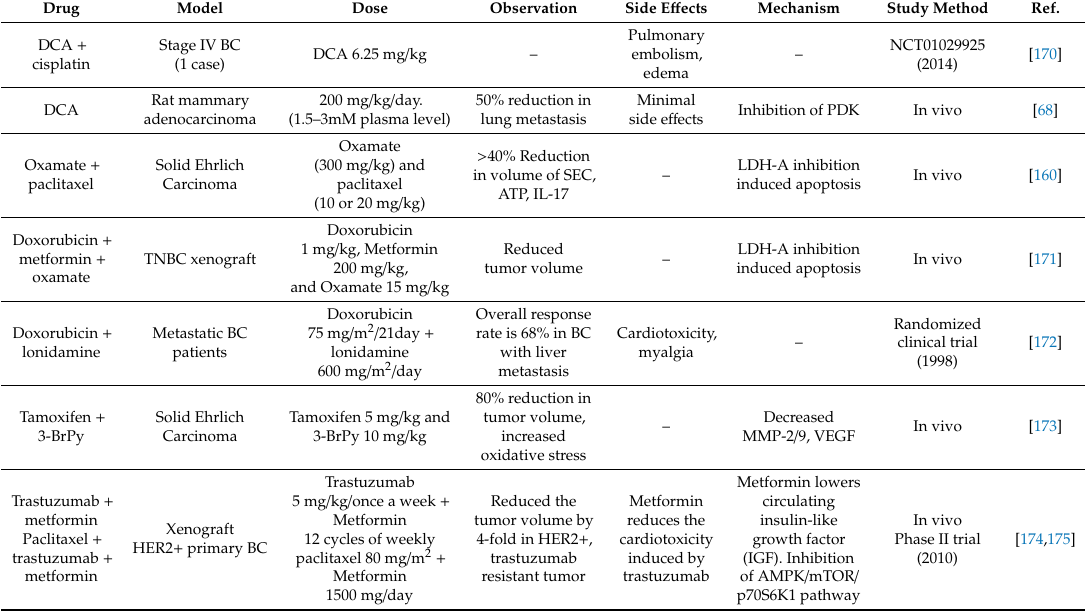
Table 2. Combination therapy with glycolytic inhibitors in BC